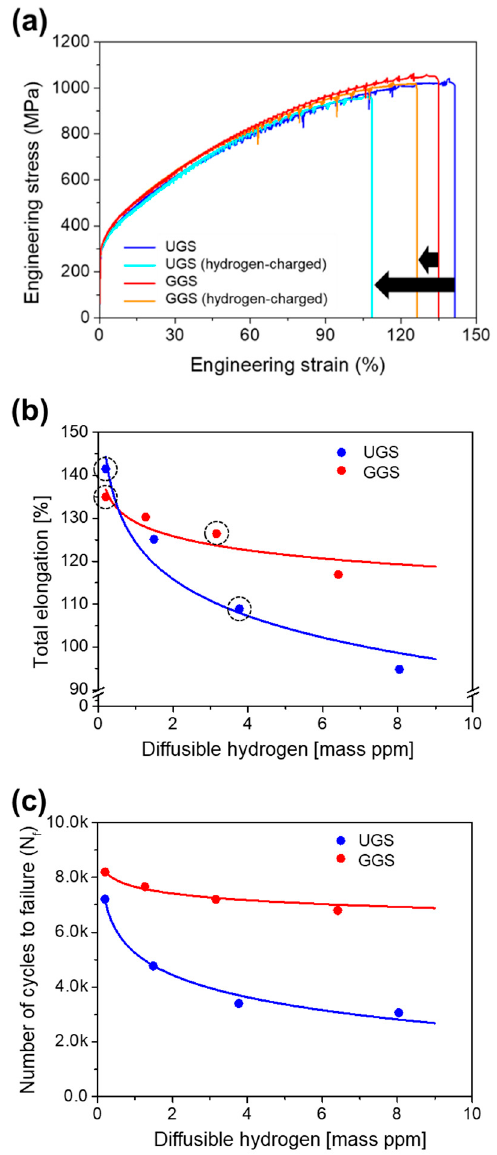
Figure 2. Variation in mechanical behaviors after hydrogen charging in the ( a , b ) monotonic and ( c ) cyclic deformation modes. Engineering stress–strain curves in Figure 2a correspond to the data points marked by the dotted circles in Figure 2b. In Figure 2a, hydrogen was charged at a current density of 30 A·m − 2 for 6 h at 360 K.